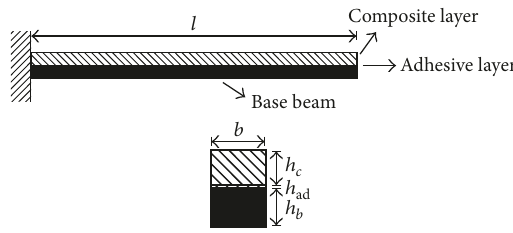
Figure 1: Geometry and cross section of a laminated composite